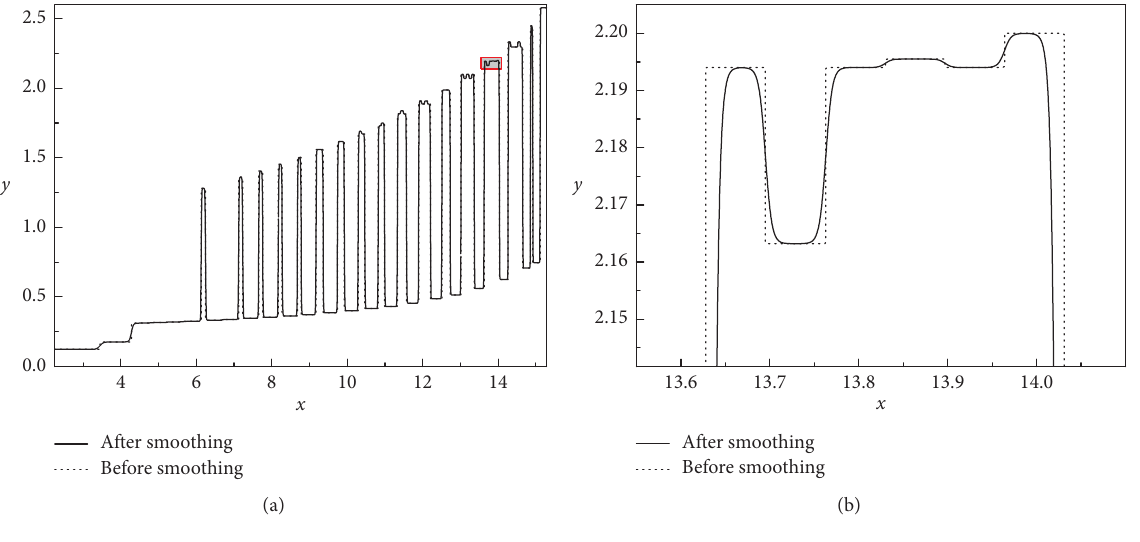
Figure 14: Sliding surface differential comparison diagram.